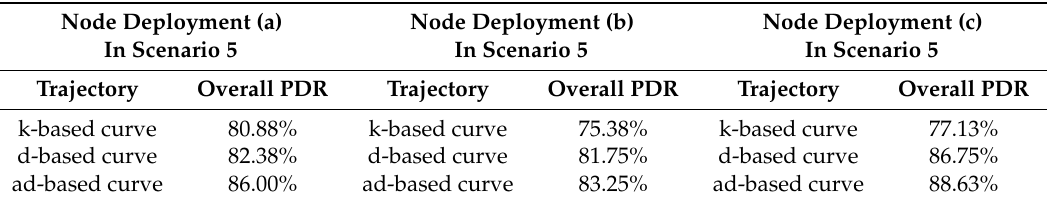
Table 5. The Overall PDR of k-based, d-based and adjustable d-based curves in Scenario 5. Node Deployment (a) Node Deployment (b) In Scenario 5 Node Deployment